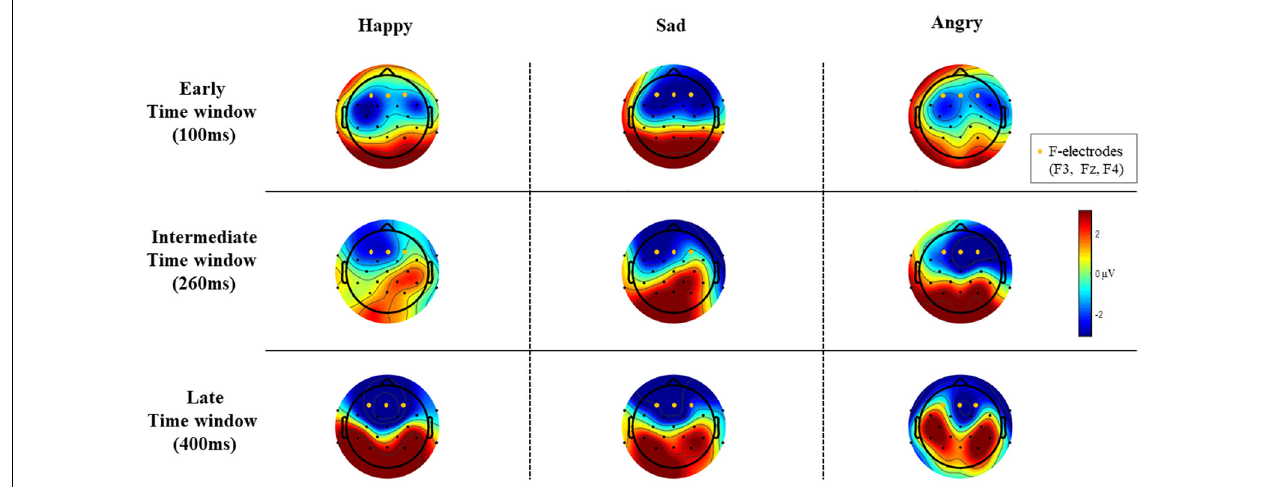
FIGURE 3 | The difference wave amplitudes (mismatch responses) of all EEG electrodes in each time window ( µ